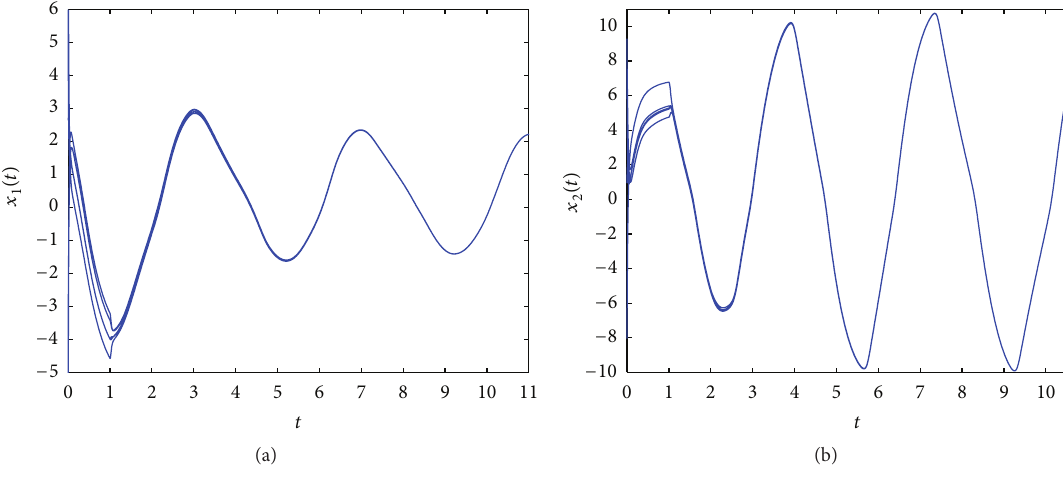
Figure 2: Time response of 𝑥 𝑖1 (𝑡) (a) and 𝑥 𝑖2 (𝑡) (b), 𝑖 = 1, 2, .. ., 5 .